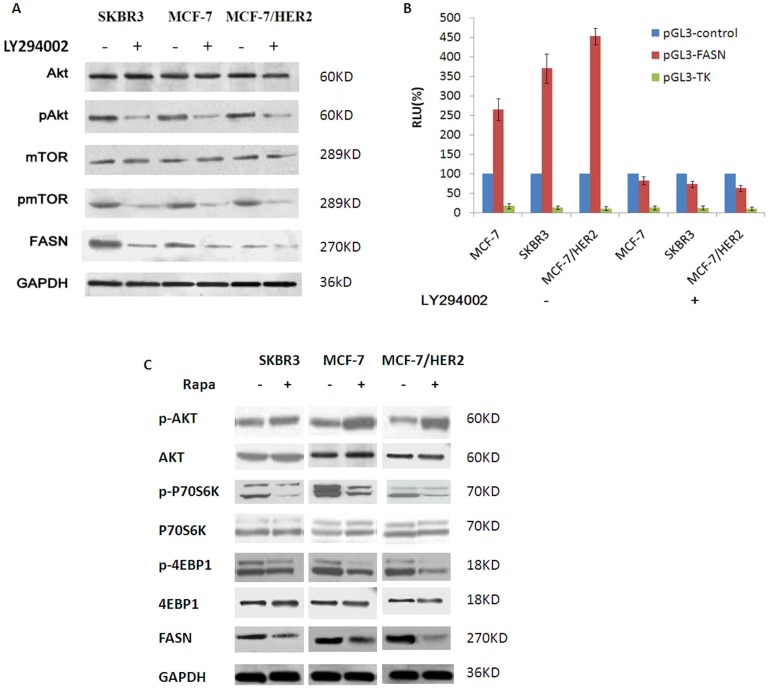
The PI3K/AKT/mTOR pathway was involved in regulating FASN expression in ER+/HER2+ breast cancer cells.A, PI3K inhibitor LY294002 (25 µmol/L, 12 h) could down-regulate the expression of pAKT, pmTOR and FASN but had no effect on the expression of total AKT or mTOR. B, The transcriptional activity of FASN promoter was obviously decreased in all the three breast cancer cell lines in response to LY294002(25 µmol/L, 12 h). The decrease in the transcriptional activity of the FASN promoter was most pronounced in MCF-7/HER2 cells (MCF-7/HER2 86.09%; SKBR3, 80.27%; and MCF-7, 69.05%). C, mTOR inhibitor rapamycin (20 nmol/L, 12 h) up-regulated the expression of pAKT but had no effect on total AKT levels. Rapamycin (20 nmol/L, 12 h) could up-regulate the expression of pAKT and down-regulate the expression of downstream targets of mTOR such as 4EBP-1 and pp70S6K and FASN, whereas the expression of 4EBP-1 and p70S6K did not change.